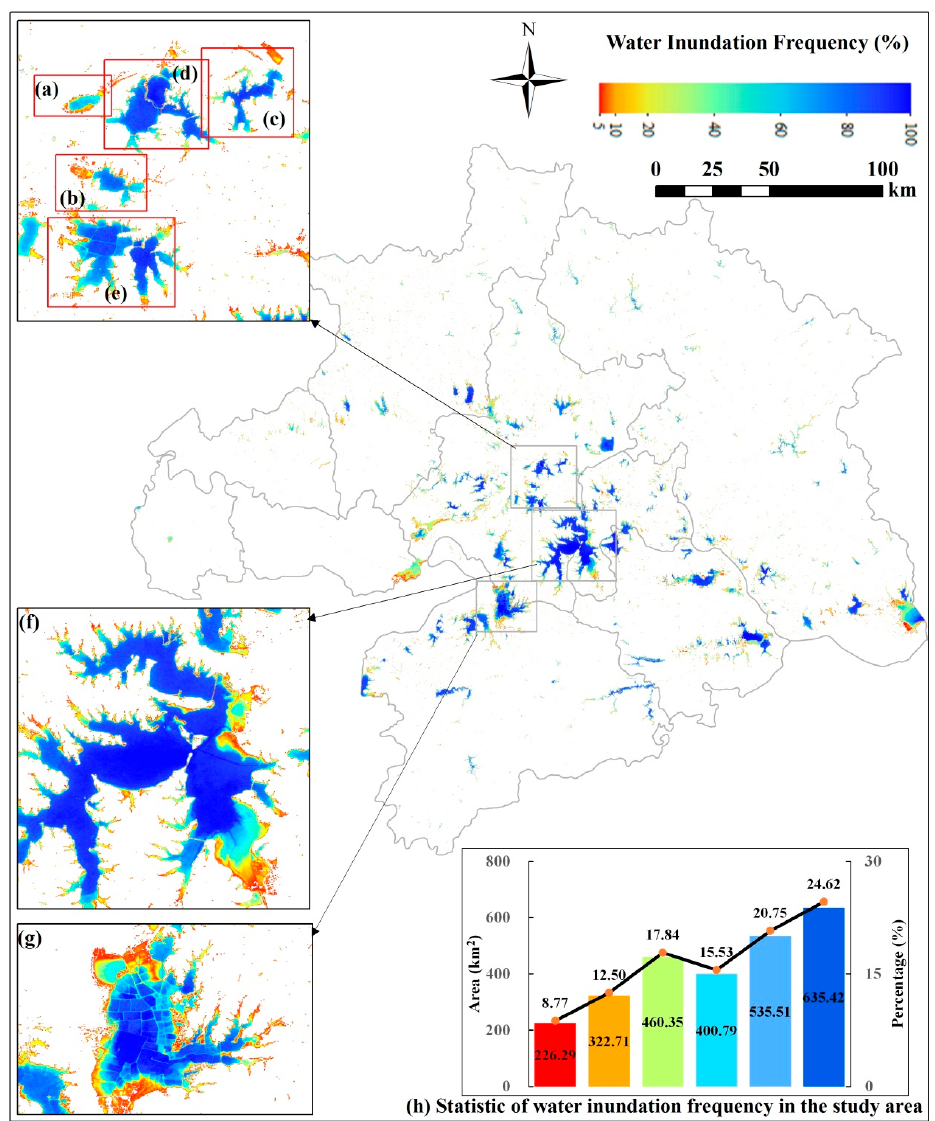
Figure 5. Water inundation frequency from 1987~2015. ( a )–( g ) represents Shahu, Nanhu, Yanxihu, Donghu, Tangxunhu, Liangzihu, and Futouhu, respectively. ( h ) shows the lake-water area at a water